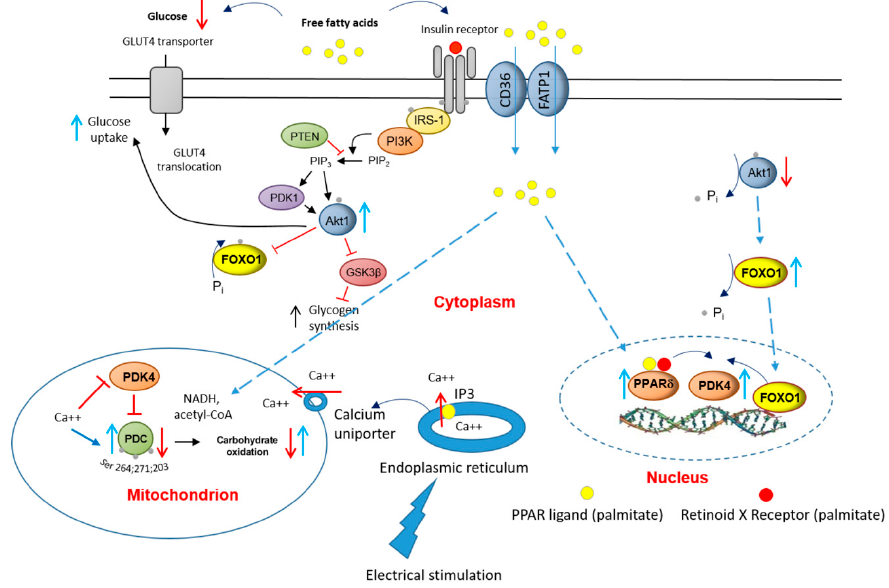
Figure 8. A schematic illustration of the underlying mechanism by which palmitate inhibits the carbohydrate (CHO) / glucose-derived pyruvate mitochondrial ATP production through activation of PPAR δ - and FOXO1-mediated upregulation of PDK4 protein. Blue upright arrow denotes upregulation and red downward arrow denotes downregulation. CD36, fatty acid translocase; FATP1 insulin-sensitive fatty acid transporter; PDK1, 3-phosphoinositide-dependent kinase-1; GLUT4, glucose transporter isoform 4; IGF, insulin-like growth factor; FFA, free fatty acid; Akt1, serine / threonine-protein kinase 1; PTEN, phosphatase and tensin homolog; PI3K, phosphoinositol 3-kinase; GSK3 β , glycogen synthase kinase; IRS-1, insulin receptor substrate